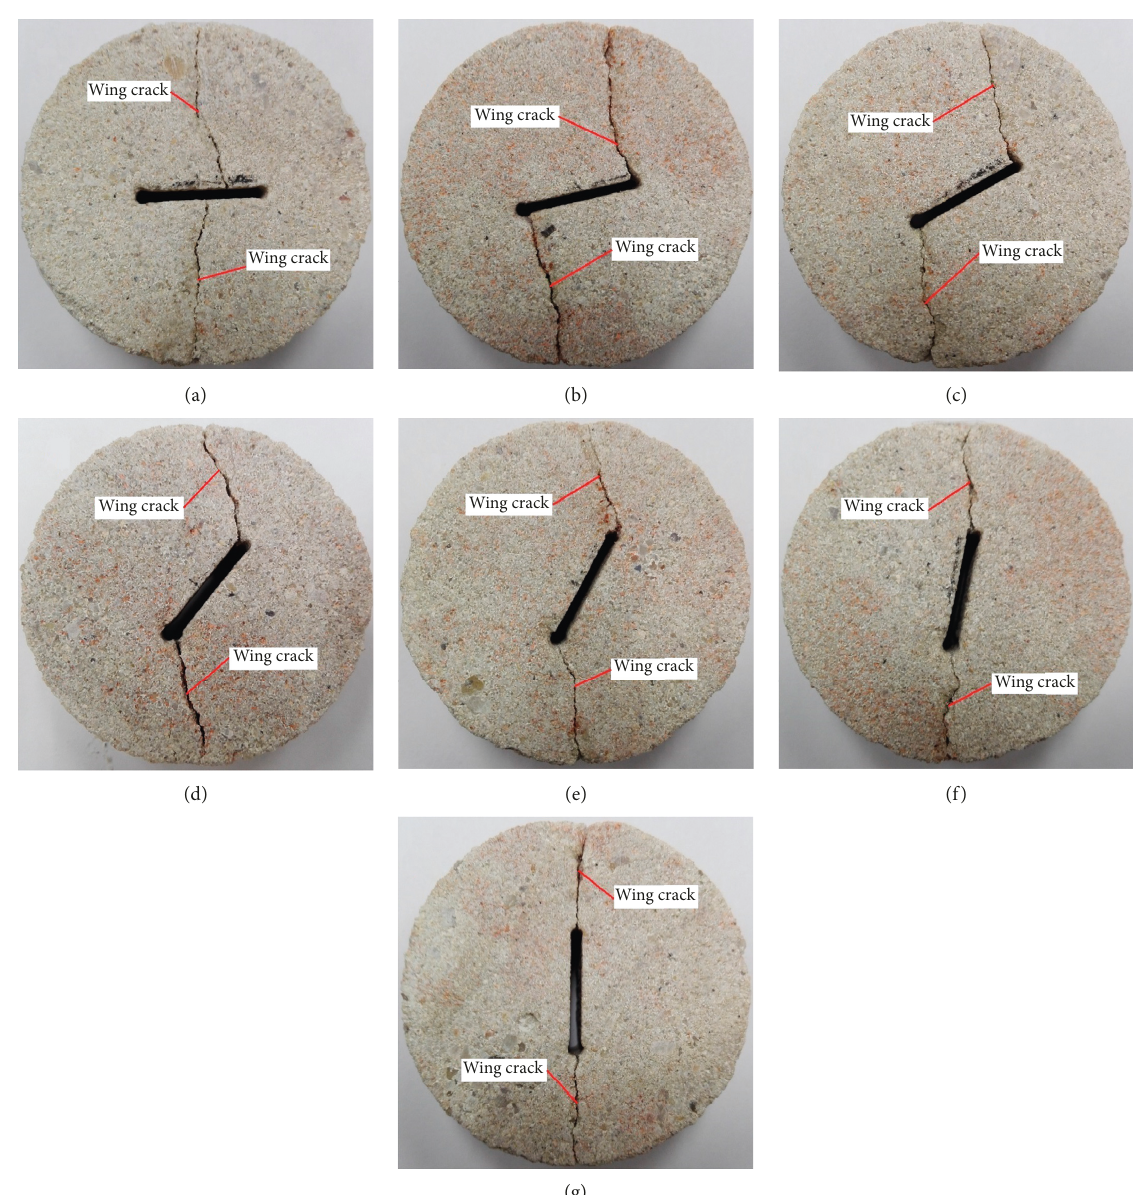
Figure 8: Experimental results of crack propagation paths in tested specimens with different pre-existing crack inclination angles: (a) β � 0, (b) β � 15 ° , (c) β � 30 ° , (d) β � 45 ° , (e) β � 60 ° , (f) β � 75 ° , and (g) β � 90 °